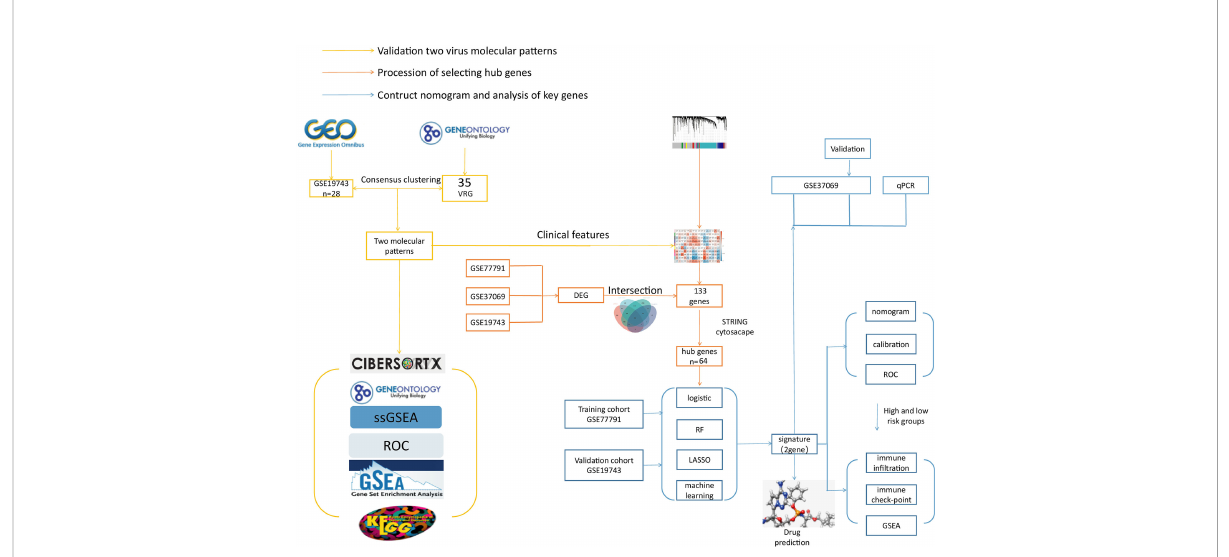
FIGURE 1 The fl ow chart. The yellow line is the validation of two viral molecular patterns. The orange line is the process of selecting hub genes. The blue line is the contructed nomogram and analysis of key